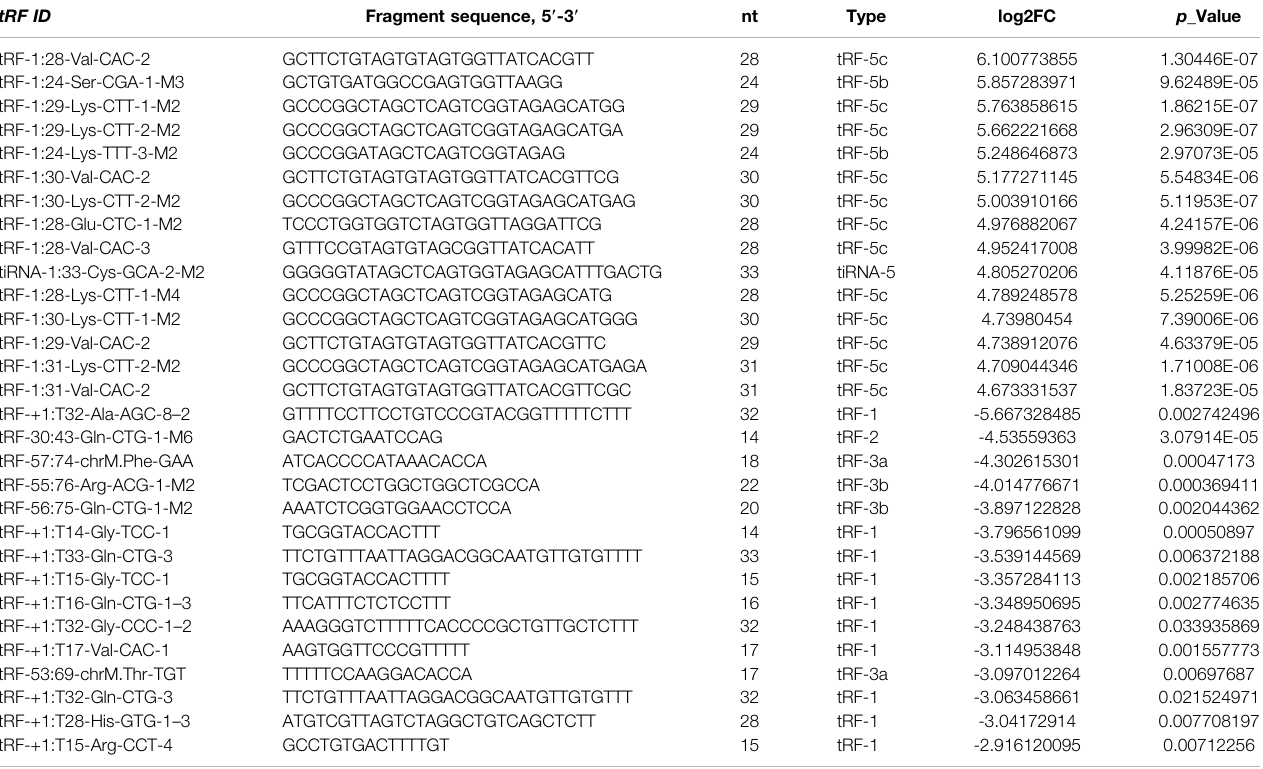
TABLE 1 | Top 15 signi fi cantly differentially expressed tRNA-derived small RNAs. tRF